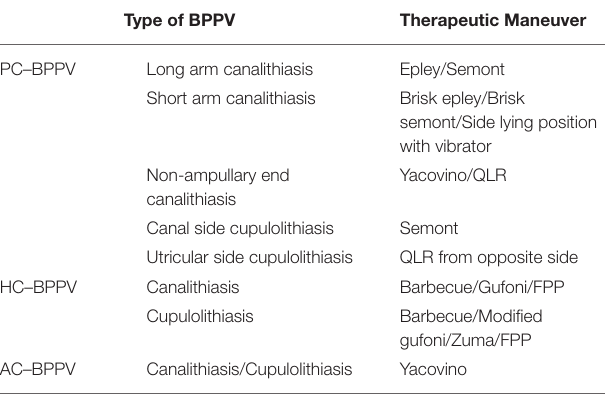
TABLE 1 | Types of BPPV and therapeutic maneuvers (PC–BPPV, Posterior canal BPPV; HC–BPPV, Horizontal canal BPPV; AC–BPPV, Anterior canal BPPV; QLR, Quick liberatory rotation); FPP, Forced Prolonged Positioning (11–16,